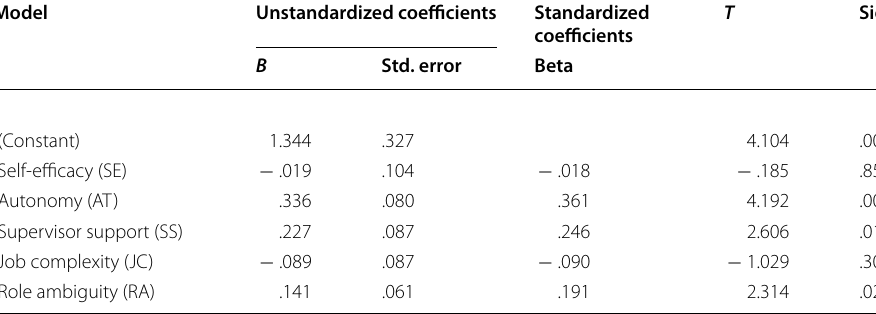
Table 6 Coefficient of study variables. Source: own survey (2020)